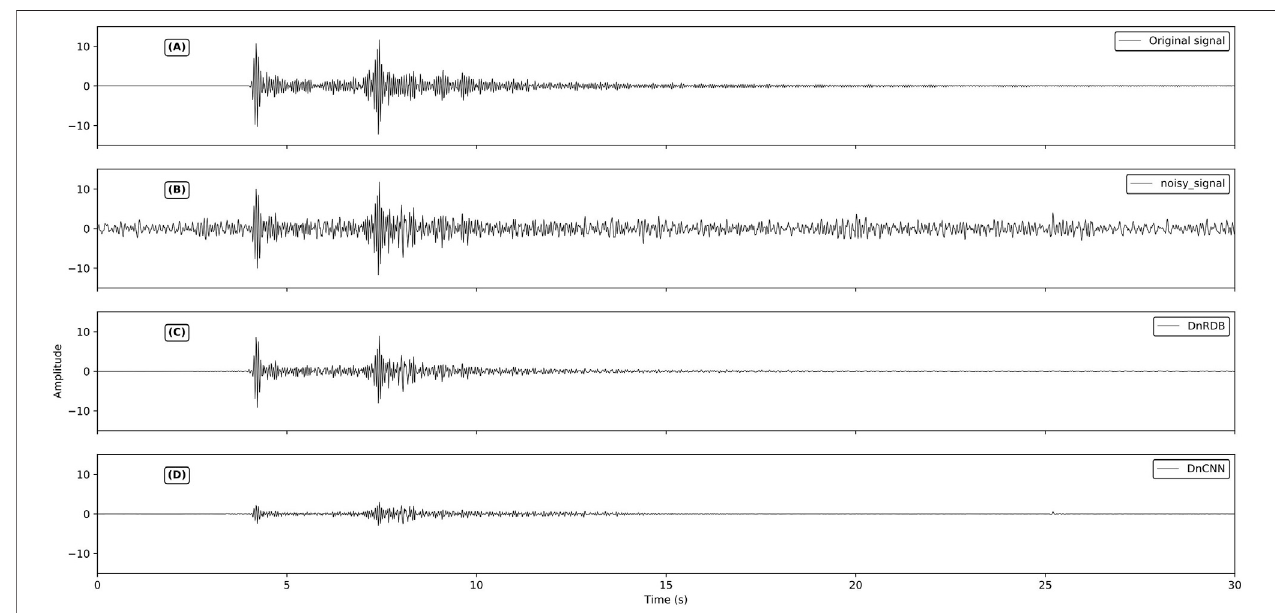
FIGURE6| Comparison ofdenoisingresultsofDnCNNandDnRDBonthesamesignal. (A) isoriginalsignal; (B) isnoisysignal; (C) isDnCNNdenoisingresult; (D) is DnRDB denoising result.